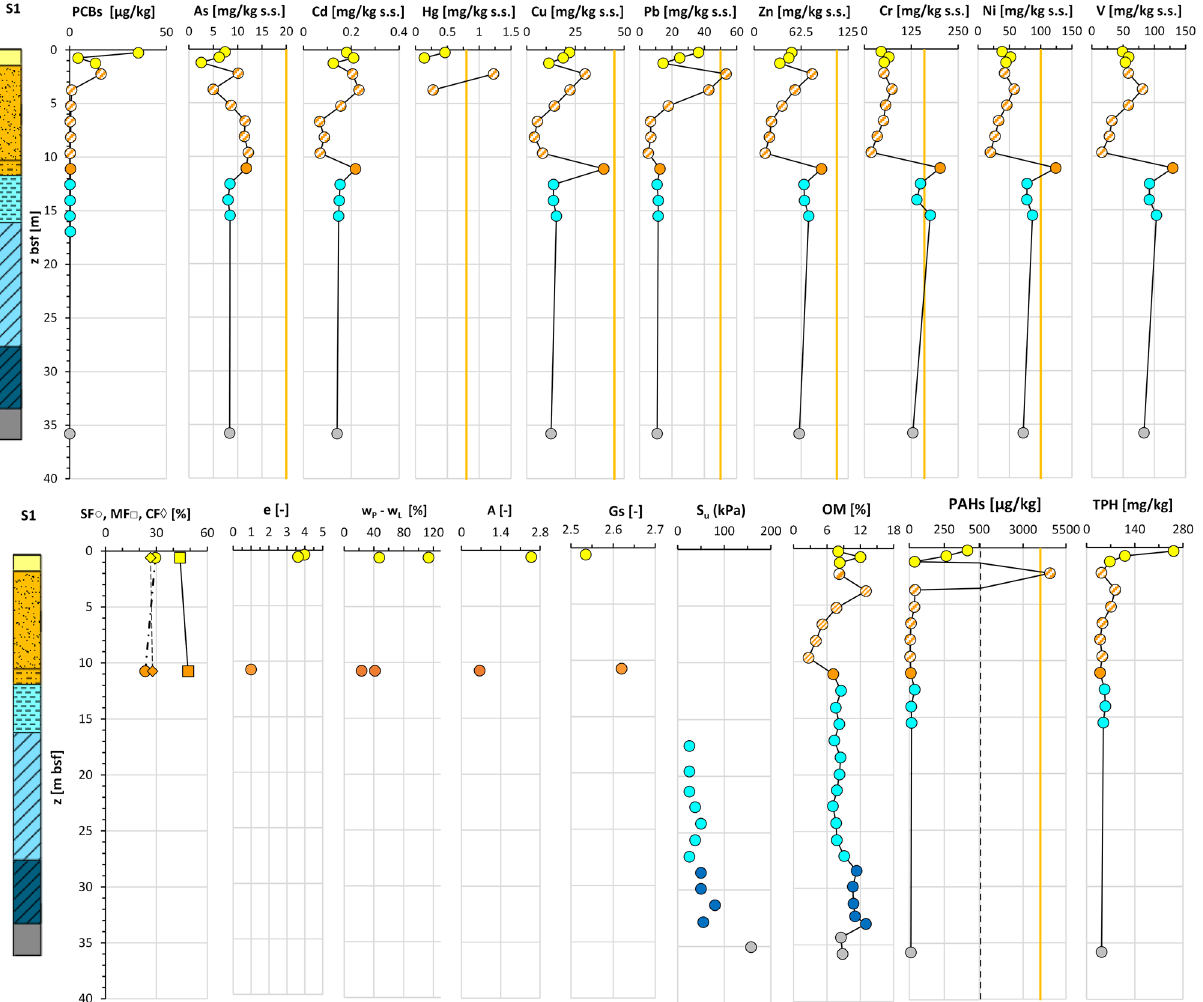
Figure 15. Vertical profiles of chemical and geotechnical properties along the S1 borehole in the I Bay of the Mar Piccolo front of the Navy area. In particular, the highest concentrations of the cited metals measured in the samples taken in the first 0.5 m depth are: Hg = 15 ppm at S6, Pb = 262 ppm at S3, Cu = 88 ppm at S6, Zn = 403 ppm at S6, As = 45 ppm at S6, Cd = 1.16 ppm at S6 (Supplementary Tab. S1). High metal concentrations are also recorded between 0.5 m and 1.5 m depth, although lower than in the top 0.5 m depth (Fig. 11). Unlike the other metals, the concentrations of Cr, Ni and V are well below the Taranto Site (yellow) threshold (Fig. 11) in the whole 1st LTU . The highest concentrations of As, Pb, Zn and Cu were recorded to occur within the top 0.5 m sediment layer of the 1st LTU also through the PRXF technique (Fig. 14). Since this technique detects the concentrations within spots of 6 mm diameter, very high concentrations of some metals were detected through its application also down to 4.0–5.0 m depth, as shown in Fig. 14. Within the first 0.5 m stratum of the 1st LTU , the highest concentrations of the organic contaminants were recorded too (e.g. the overall sum of either the congeners of PCBs, or the congeners of PAHs), found to exceed even the National Environmental Law (red) threshold at several sites (Fig. 11). In particular, the highest values were recorded at S2 for ΣPAH 16EPA (9775 ppb), at S6 for ΣPCB 31 (6828 ppb), and at sites S2, S4, S6, S3 for TPH (750 ppm; Fig. 11). The concentration of the organic contaminants reduces below 0.5 m depth. In the 2nd LTU and 3rd LTU, both the geotechnical indices PI and A reduce with increasing depth (Figs. 11 and 12), tending to the values typical for the Pleistocene ASP clays 33,41,99,100 . Also the void ratio and the liquid- ity index decrease, due to both the compression of the sediments under burial and the reduction in content of either the OM or the contaminants. However, in the 2nd LTU the soil void ratio, the liquidity index and he OM content of the fine sediments may be still quite high by 5 m depth (Figs. 11 and 12). As expected 97,101 , a lower OM content is recorded in the sandy layer in the western part of the section (OM = 2.5%), which is, therefore, less capable to trap the contaminants, with respect to the surrounding finer soils. As to the physicochemical properties, in the 2nd LTU the pH values (Fig. 15b) change among the different sites, although they keep being from neutral and slightly alkaline in the eastern sites, S6 and S7, and tend to increase in the sandy layer intercepted in the western sites. The negative